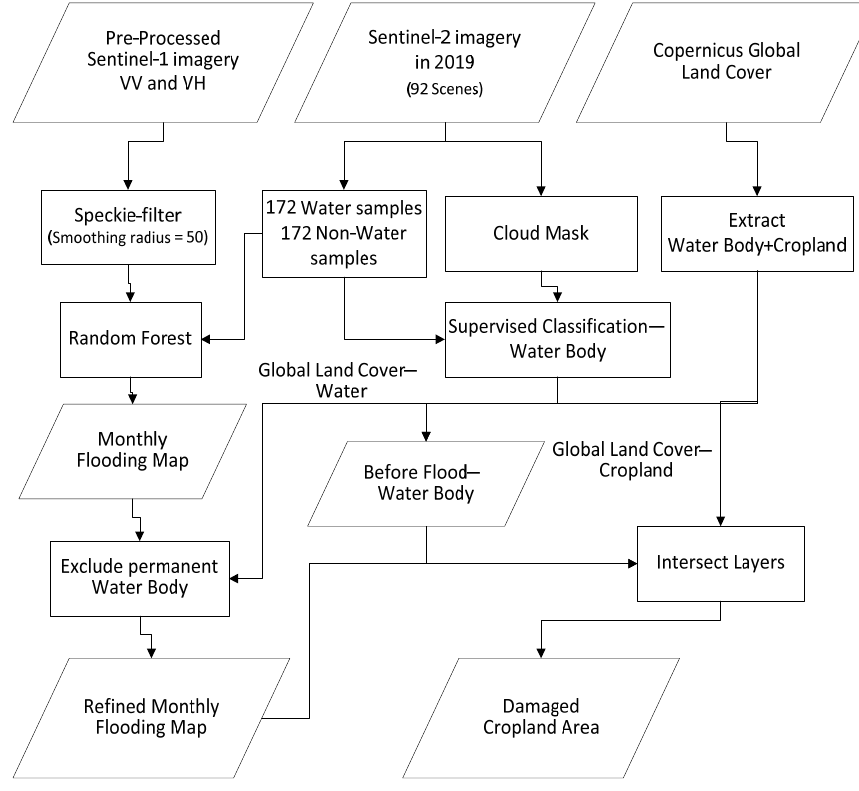
Figure 6. Workflow